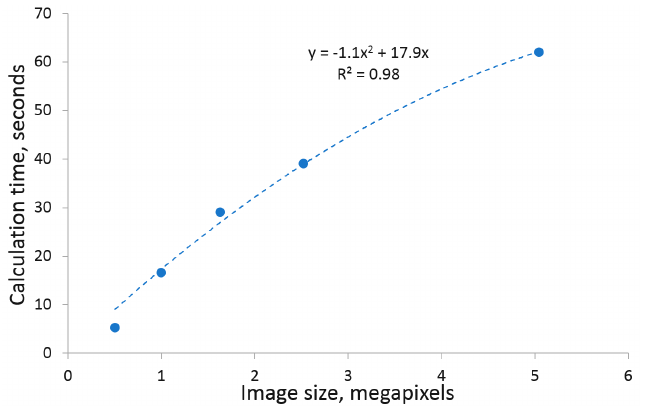
Figure 9. Computational performance of k-means clustering (without any manual editing) by segmentation of greenhouse plant images in dependence on the image